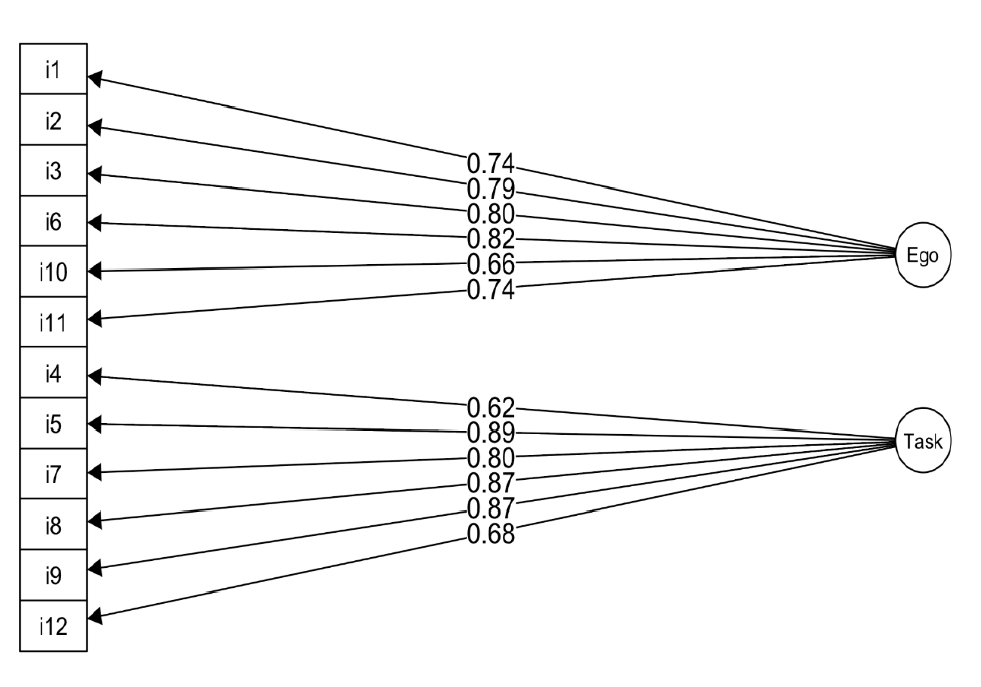
Table 2. Invariance measurement across gender for the POSQ questionnaire.